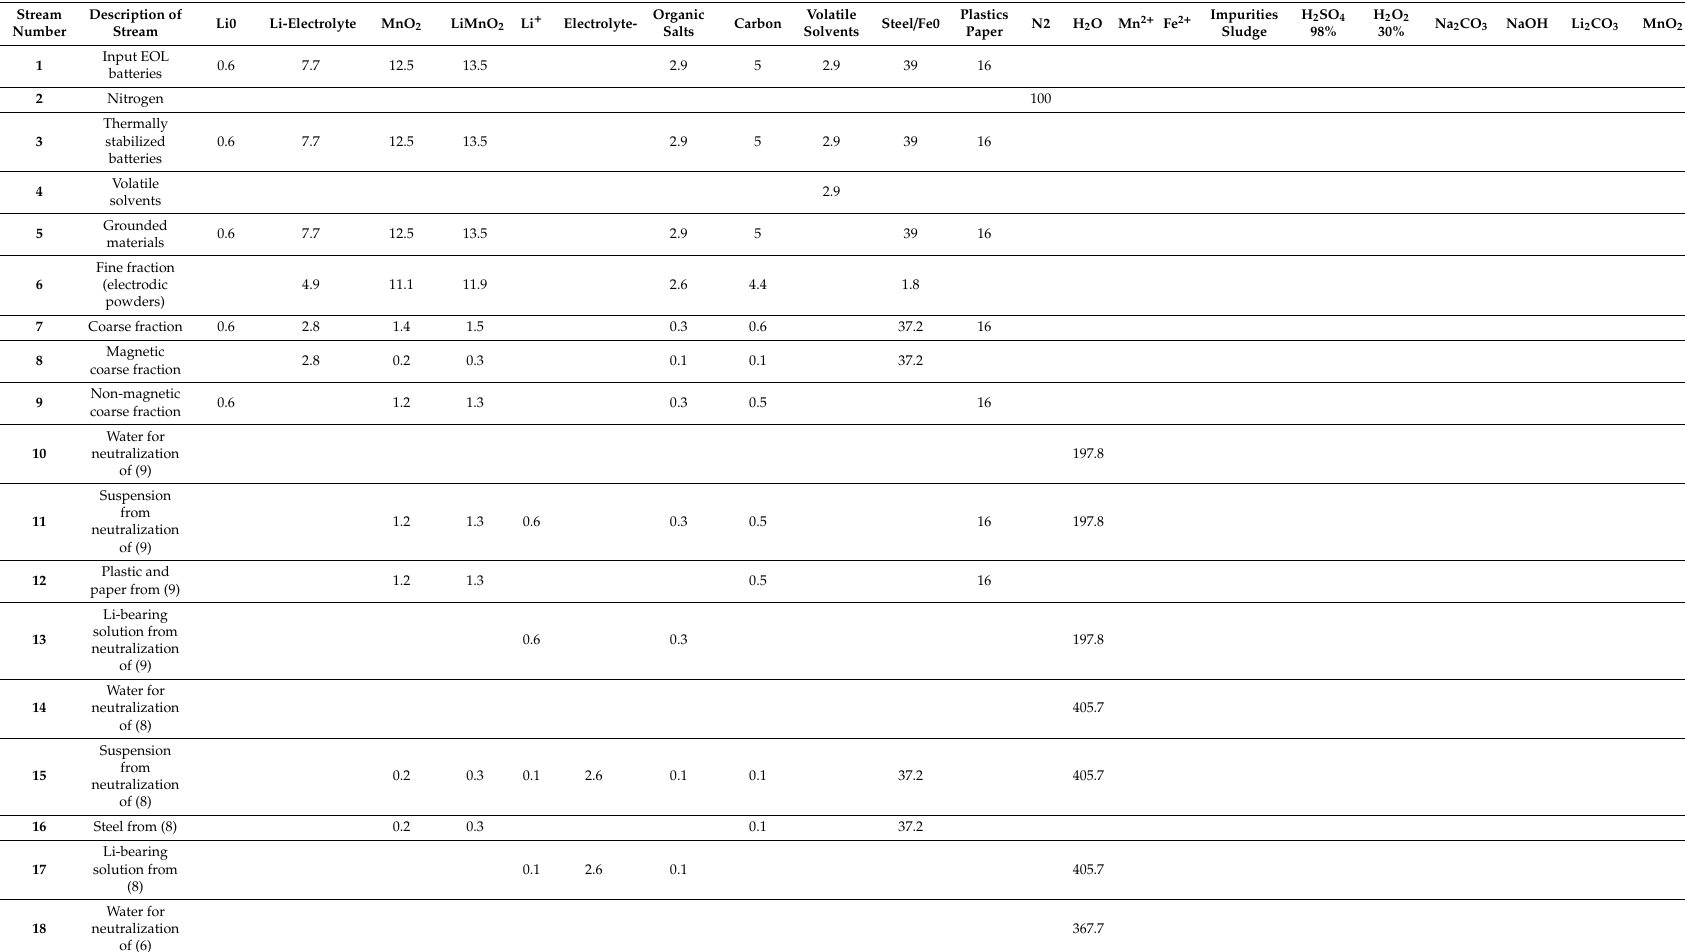
Table 4. Material composition feeding 100 Kg of coin cells and cylindrical cells (50% + 50%) in the LIBAT process. Stream Descriptionof Number